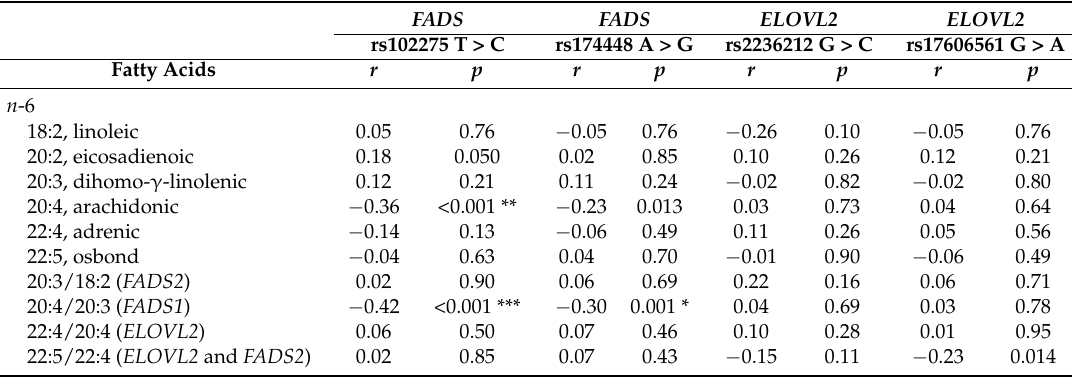
Table 6. Associations between 13 years of age serum proportions of n -6 and n -3 PUFAs (% of total FA) and fatty acid desaturase ( FADS ) and elongase ( ELOVL ) polymorphisms. FADS FADS ELOVL2 ELOVL2 rs102275 T > C rs174448 A >